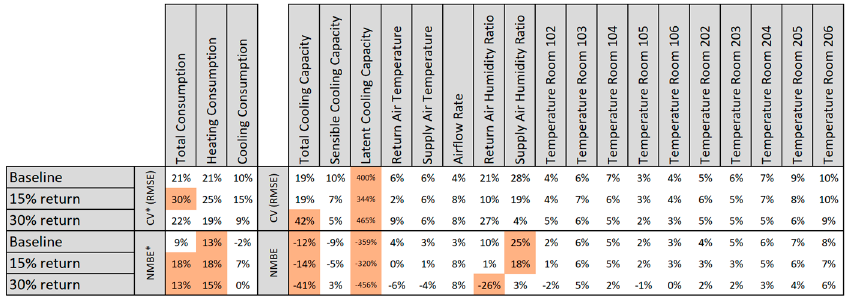
Table 12. CV (RMSE) and NMBE Calculations for Detailed Model Outputs: Return Air Duct Leakage.